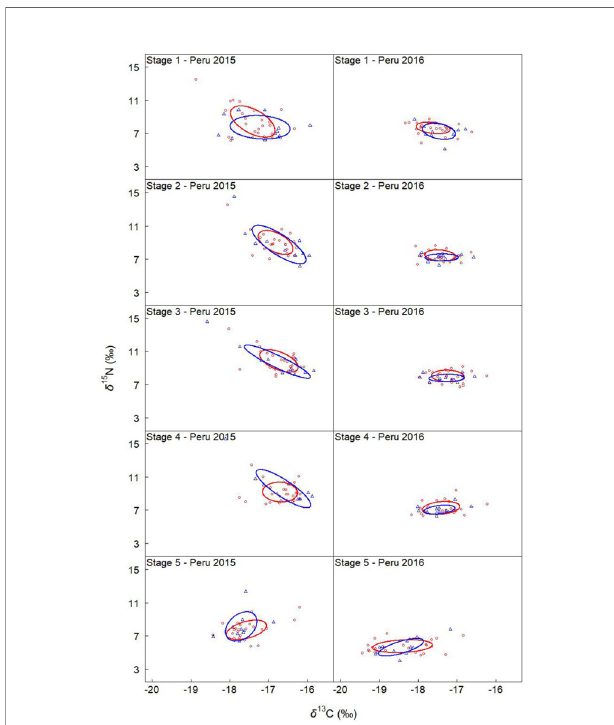
FIGURE 6 | Sexual variation in the isotopic niche off Peru in 2015 and 2016. Solid lines enclose the standard ellipse areas (SEAc), showing the isotopic niche of females and males (red and blue represents female and male, respectively). “ Peru 2013 ” represents the samples collected off Peru during 2013, and so